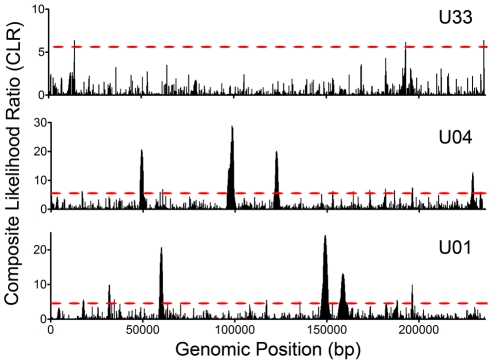
Selective Sweeps were detected within HCMV intrahost populations.Intrahost variant data was processed with the model of Nielsen et al and composite likelihood ratios (CLRs) were calculated for 235 bp windows across the HCMV genome. CLRs are measures of the probability of a selective sweep within a genomic region. Simulations were run to determine the threshold values for significance and these values are depicted as red, dashed lines across the graphs (see Figure S8 for a presentation of the simulation data). Each CLR above the threshold is considered significant and is indicative of a selective sweep occurring within the window. See Table S5 for a tabular presentation of ORFs located in statistically significant regions and the corresponding CLR and p values.